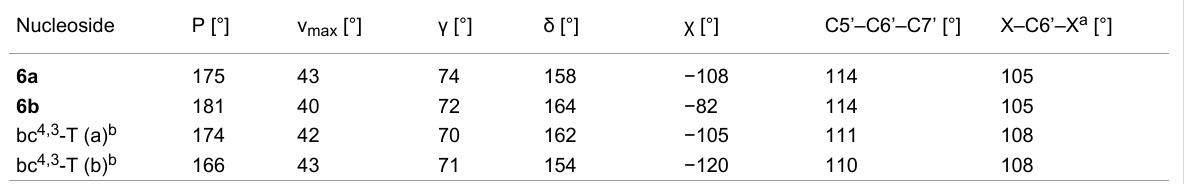
Table 2: Selected parameters from the crystal structure of nucleoside 6 and the standard bc 4,3 -T. Nucleoside